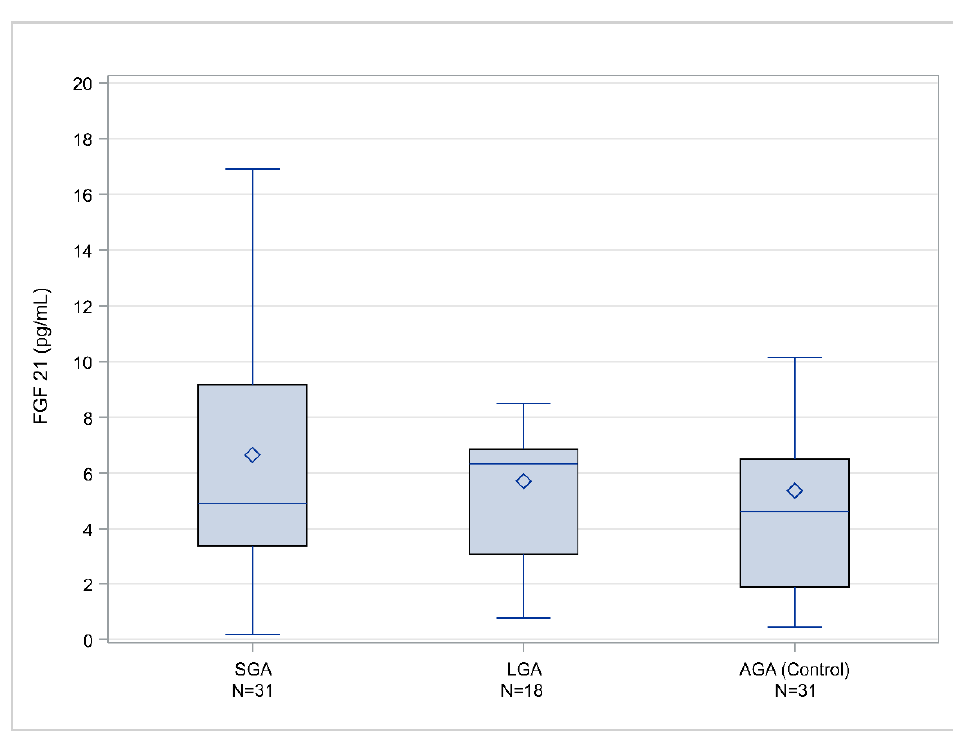
Figure 1. FGF21 values (pg/mL), box and whisker plots indicate box limits: Q1 and Q3, lines within the boxes: median value, diamond symbol: mean value, whisker limits: minimum and maximum observation after outlier exclusion. Table 2. FGF21 median values (pg/mL) and Q1–Q3 ranges by fetal size subgroups, including extremes of